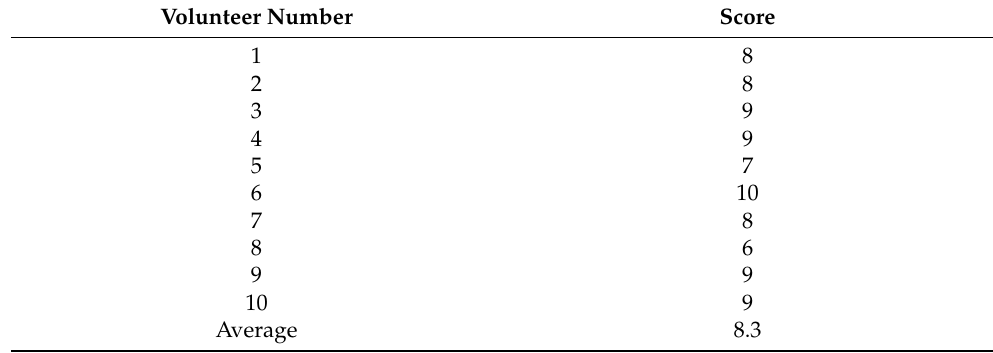
Table 4. The average score is 8.3, which proves that this function can effectively help VIPs perceive the surrounding environment. Table 4. Score for image captioning function accuracy.